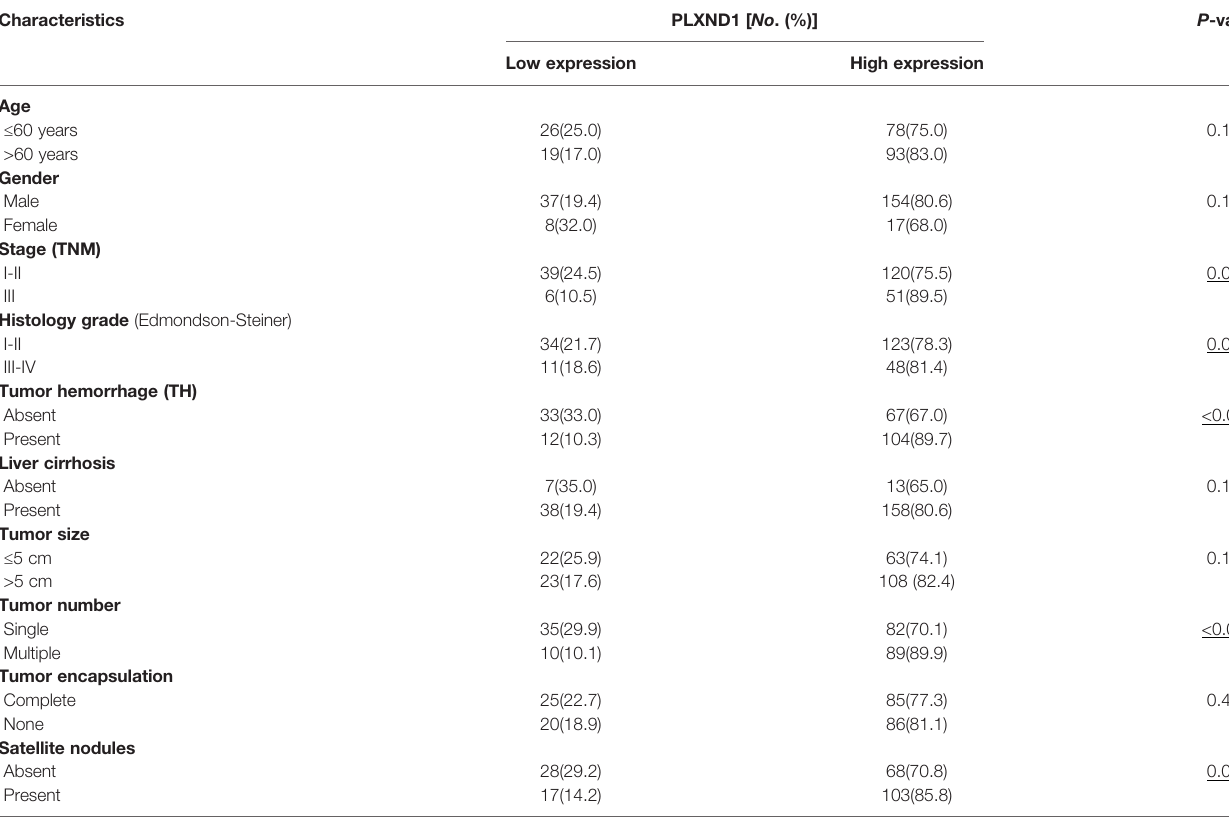
TABLE 1 | Correlation of PLXND1 expression with clinicopathological characteristics in HCC (n = 216).